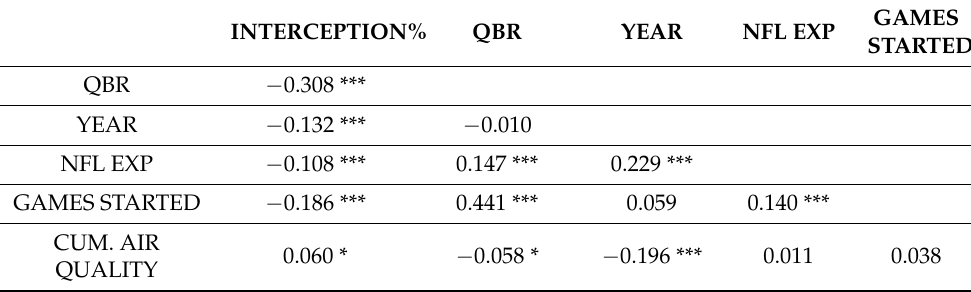
Table 5. Correlation matrix of regression variables for MLB